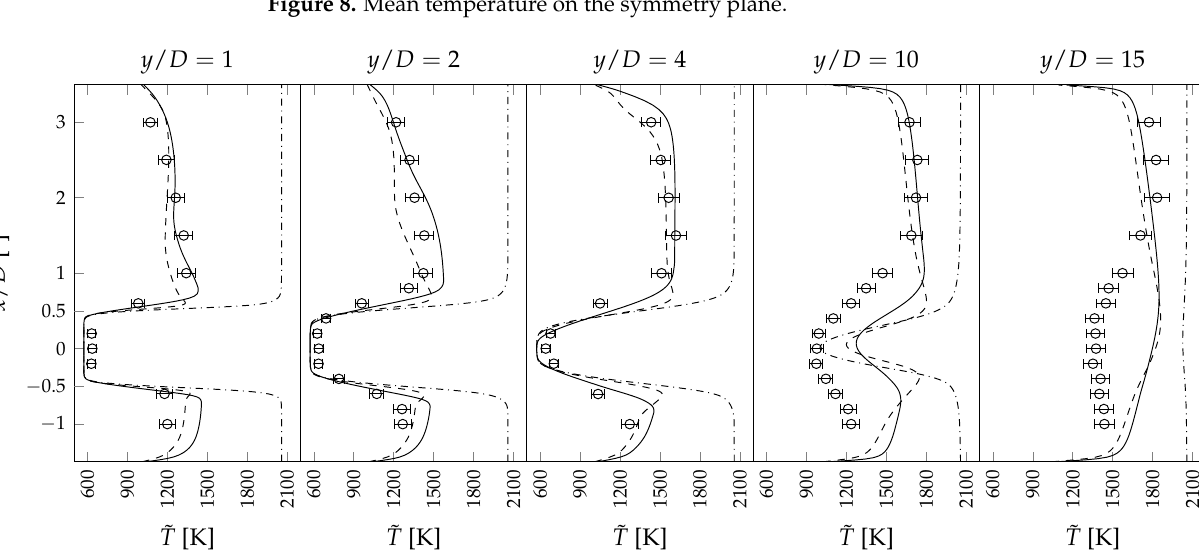
Figure 13. Mean temperature profile plots at various stream-wise locations. FGM-NAC ( ), Figure 9. Mean temperature profile plots at various stream-wise locations. FGM-NAC (——), FGM-NA ( ), FGM-A ( ), Raman measurement results ( ) [2].